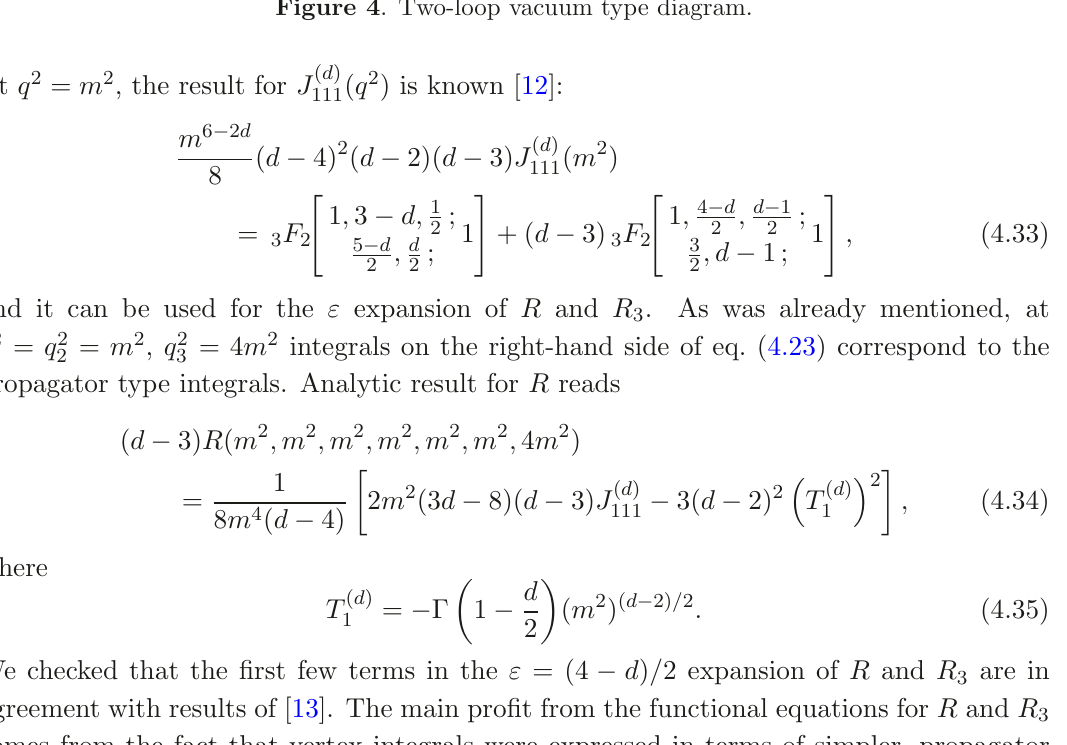
Figure 4 . Two-loop vacuum type